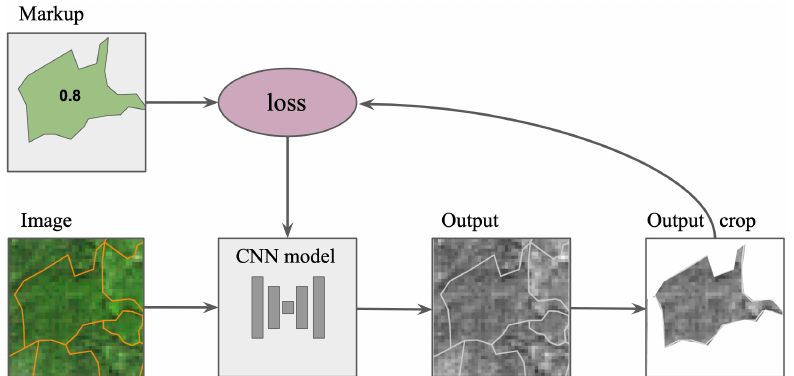
Figure 6. The object-wise semantic segmentation approach. The model produces the map where the probability of a class is recorded at each pixel. Loss is computed just for masked area of the polygon. The percentage of dominant class is also can be taken into consideration (in the example, the dominant species percentage for the individual stand is